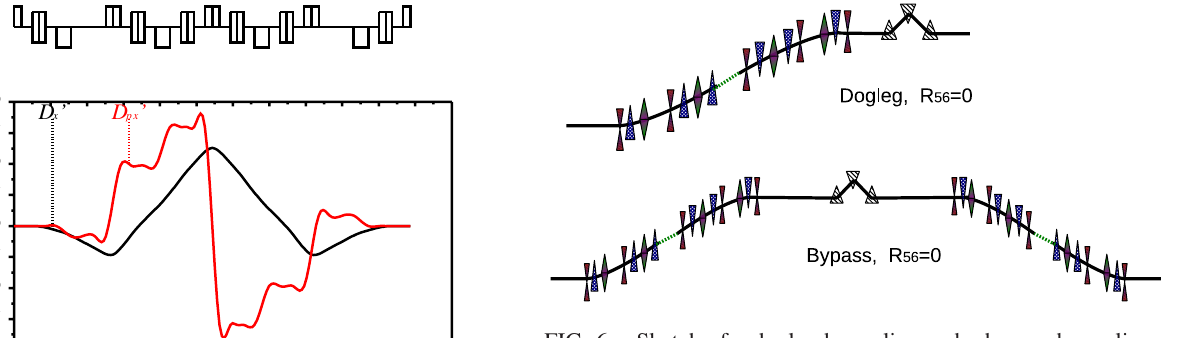
FIG. 6. Sketch of a dogleg beam line and a bypass beam line, ¼ 0 in both R 56